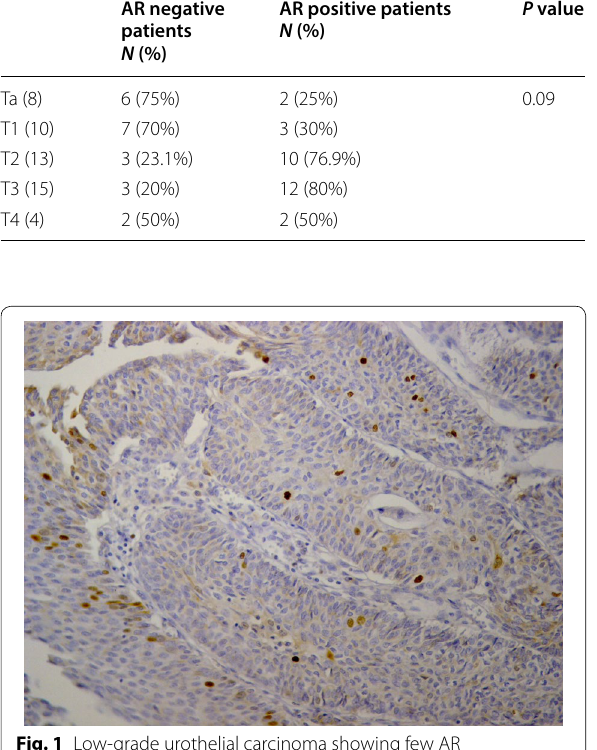
Fig. 1 Low-grade urothelial carcinoma showing few AR immunoreactive tumor cells (< 10%) (